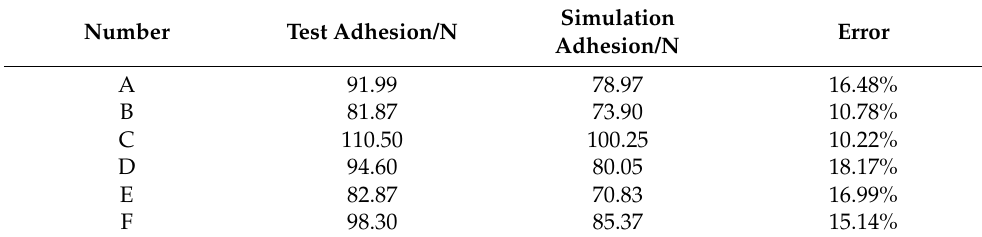
Table 3. Comparison table of tested and simulated